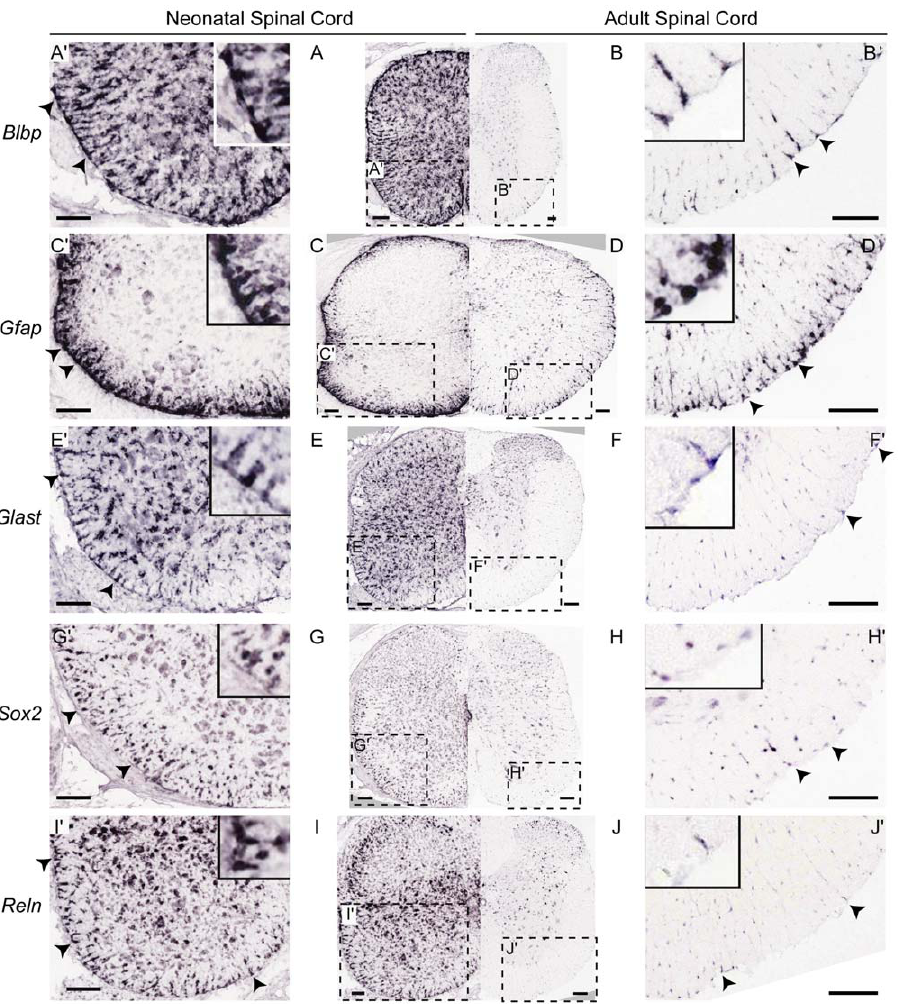
Figure 1. Radial Glia at the Pial Boundary of the Neonatal and Adult Spinal Cord. In situ hybridization images from the ASCA show that both neonatal (PND 4) and adult (PND 56) SCRG (arrowheads on soma) express genes commonly associated with embryonic RG. (A, B) Blbp (a.k.a. Fabp7 ), (C, D) Gfap , (E, F) Glast , (G, H) Sox2 and (I, J) Reln . In all cases, SCRG are prominent in the neonatal SC (A, C, E, G & I), and less abundant in the adult (B, D, F, H & J). The boxed areas correspond to the magnified images (A 9 –J 9 ) and inserts show high magnification of SCRG. Reln: Reelin. Scale bars: 100 m m.